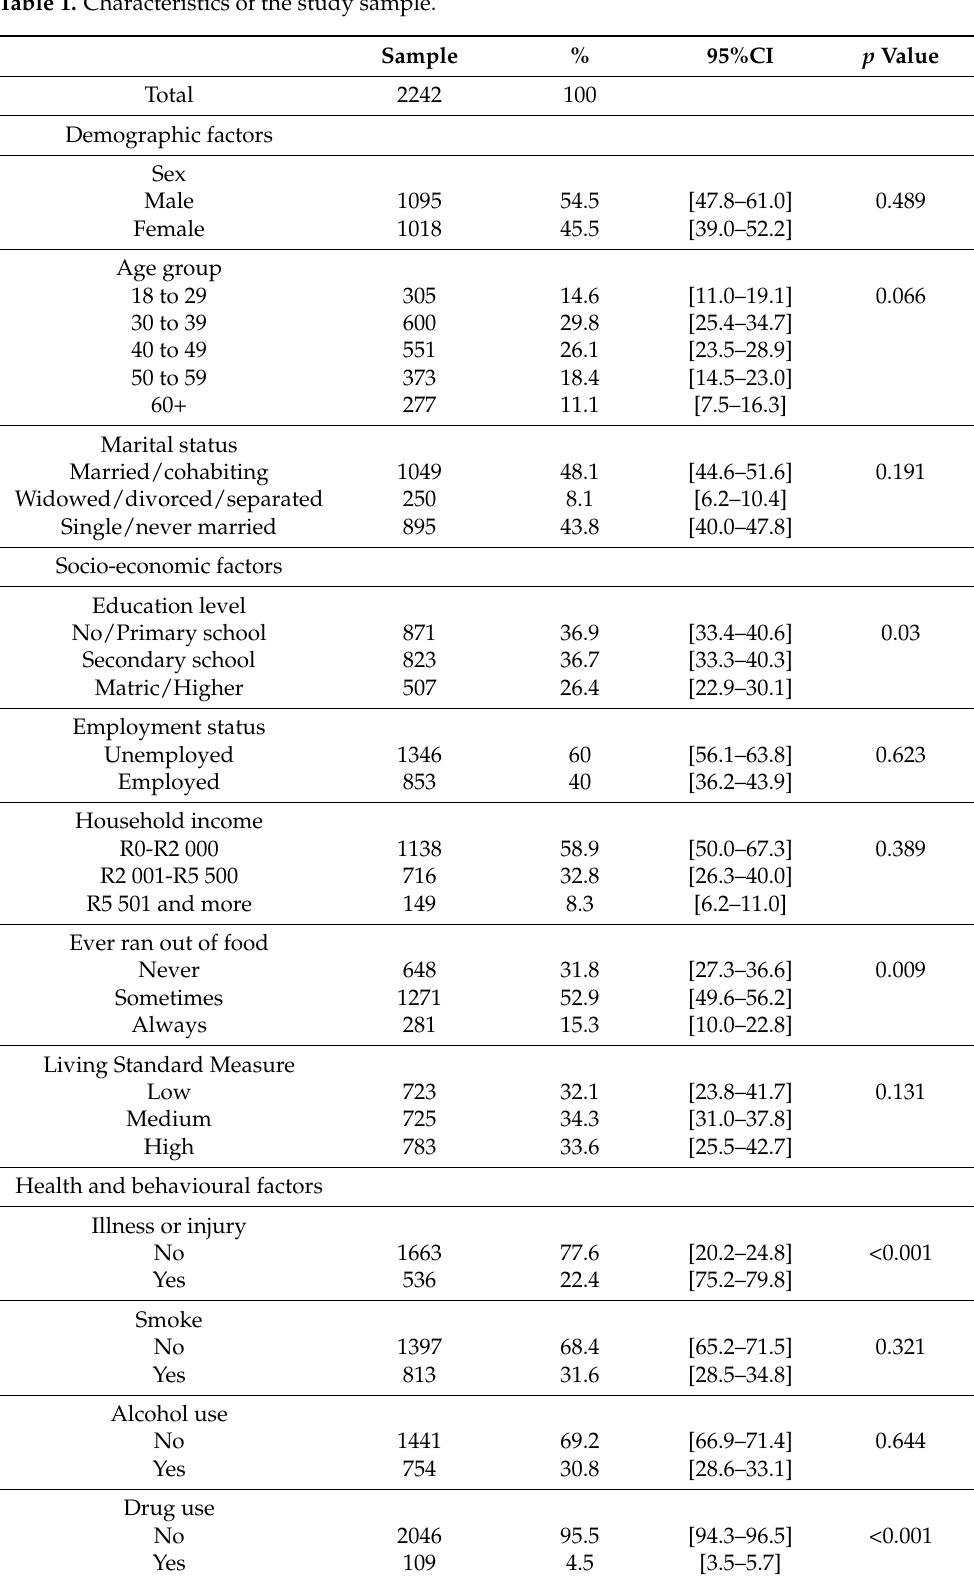
Table 1. Characteristics of the study